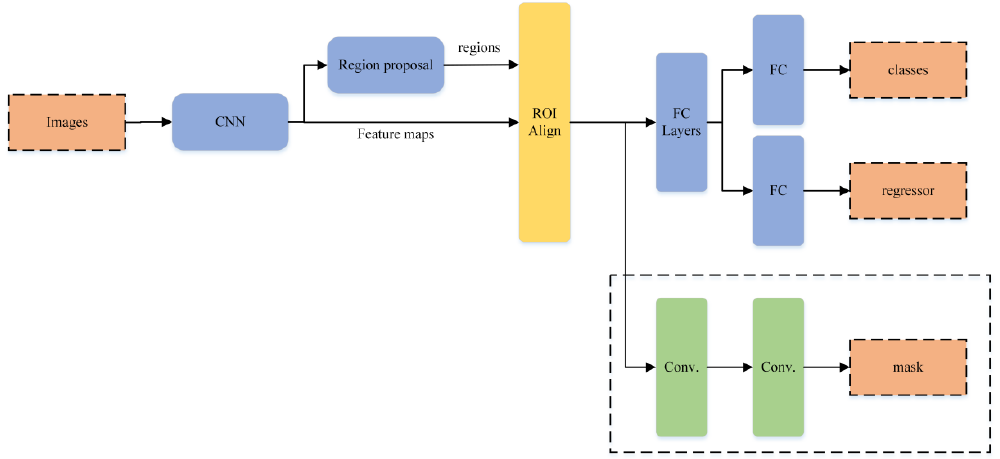
Figure 2. Mask R-CNN model structure.